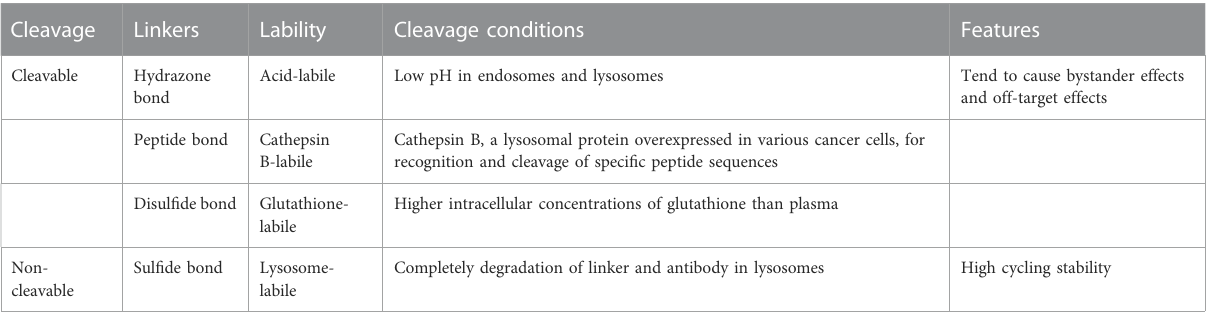
TABLE 1 Linkers types and features.